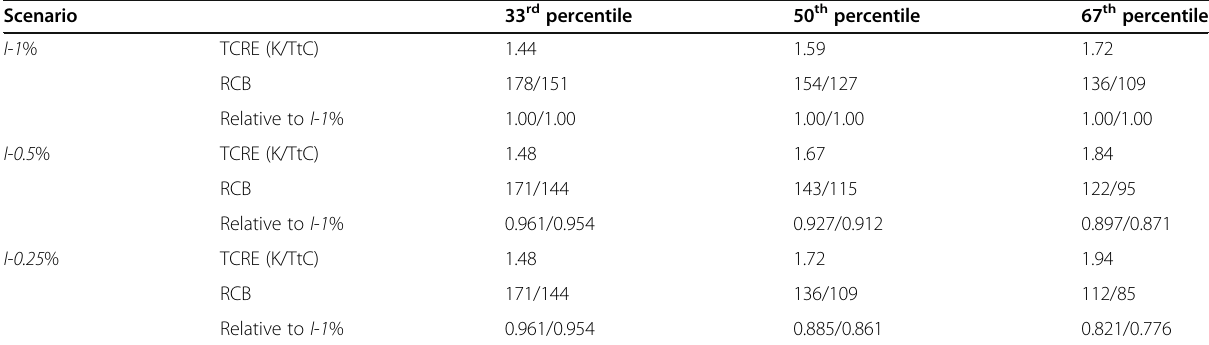
Table 4 Remaining carbon budget (RCB) for the 1.5 °C target based on the TCREs for the I - 1 %, I - 0.5 %, and I - 0.25 % scenarios Scenario